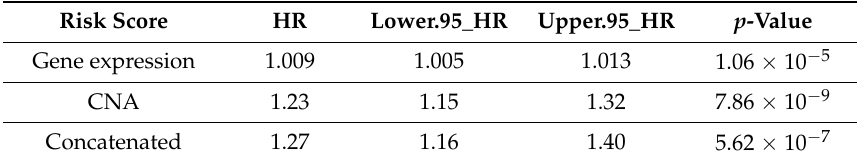
Table 3. Cox’s proportional hazards (COX-PH) results for risk scores.